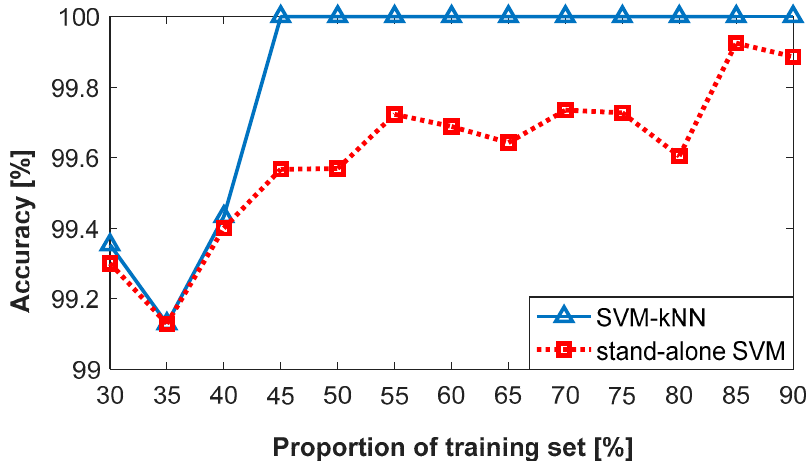
Figure 13. Classification results of the SVM-kNN and stand-alone SVM with the three principal components.